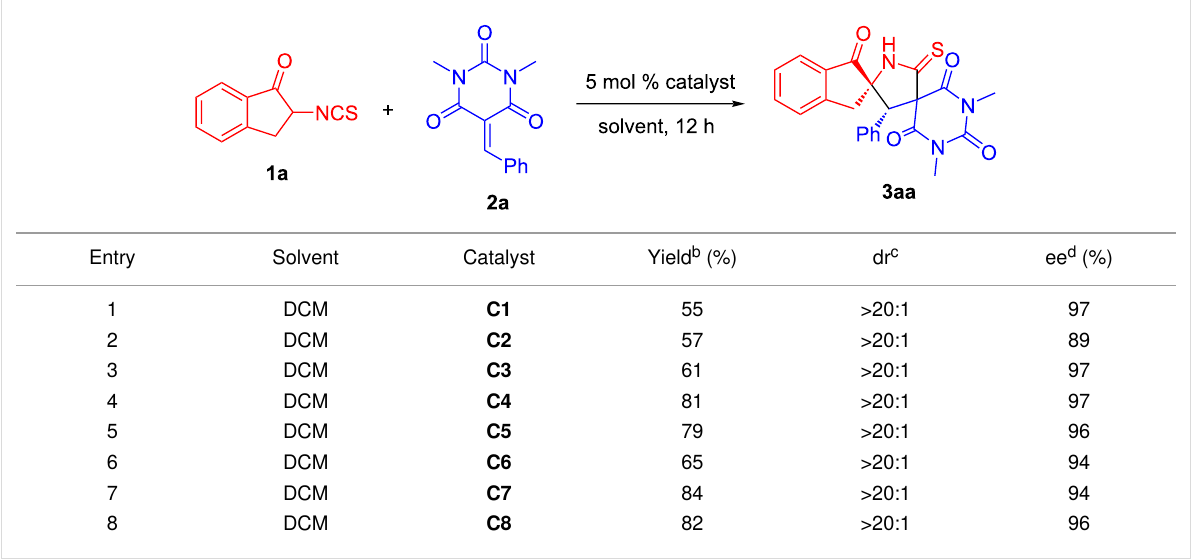
Table 1: Optimization of the reaction conditions a